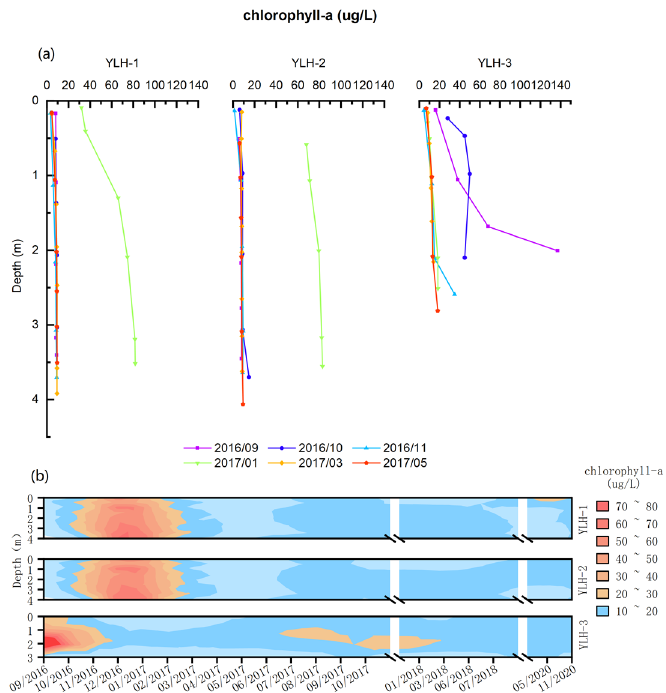
Figure 4. Seasonal and interannual variations in Chl-a in lake Yilong. ( a ) Seasonal variations in water temperature; ( b ) Interannual variations in water temperature.